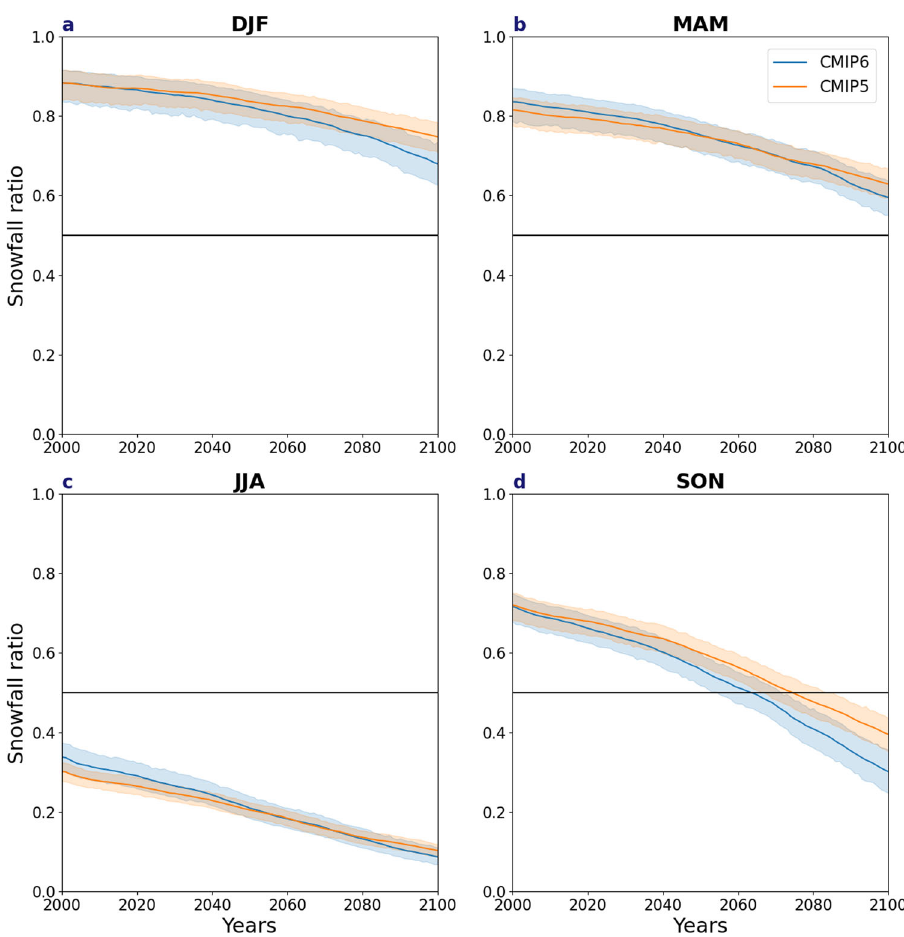
Fig. 9 Time evolution of the snowfall ratio. The snowfall ratio over time. The horizontal lines denote the transition from a snow- to rain-dominated precipitation at (0.5) for CMIP6 (blue) and CMIP5 (orange) for a December – February (DJF), b March – May (MAM), c June – August (JJA), d September – November (SON). The shading indicates 5th – 95th model spread for each and all data are averaged as a 10-year rolling